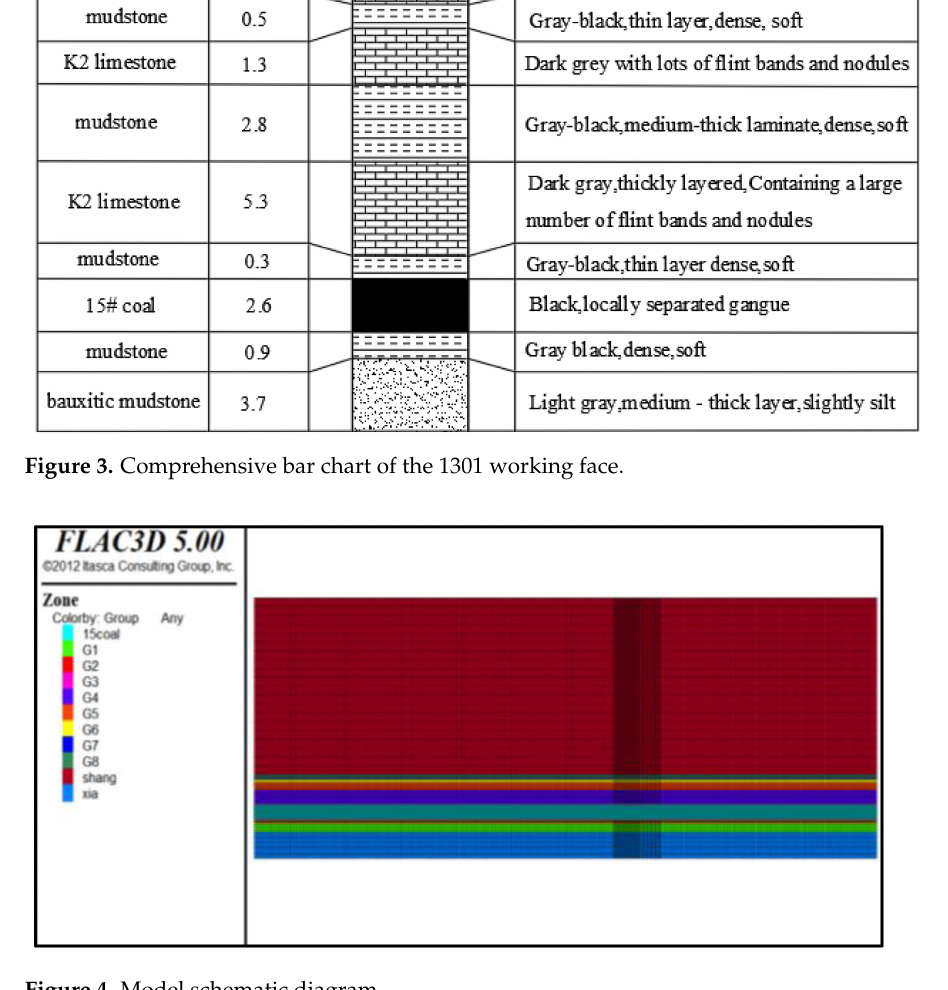
Figure 4. Model schematic diagram. Table 1. Material parameters of